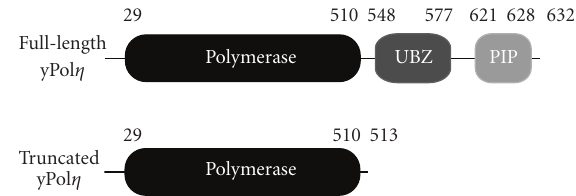
Figure 1: Schematic illustration of yPol η . The polymerase domain of yPol η is at the N-terminus while a ubiquitin-binding zinc finger (UBZ) domain and PCNA-interacting peptide (PIP) motif is at the C-terminus. Residue numbers are denoted above each region. For this study, the truncated construct contains only the polymerase domain.